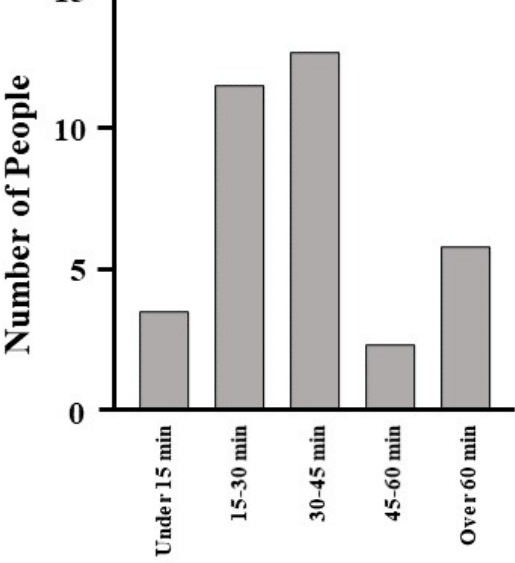
Figure 5. Time required for external committee members to get to institutional review board meeting sites at university hospitals in